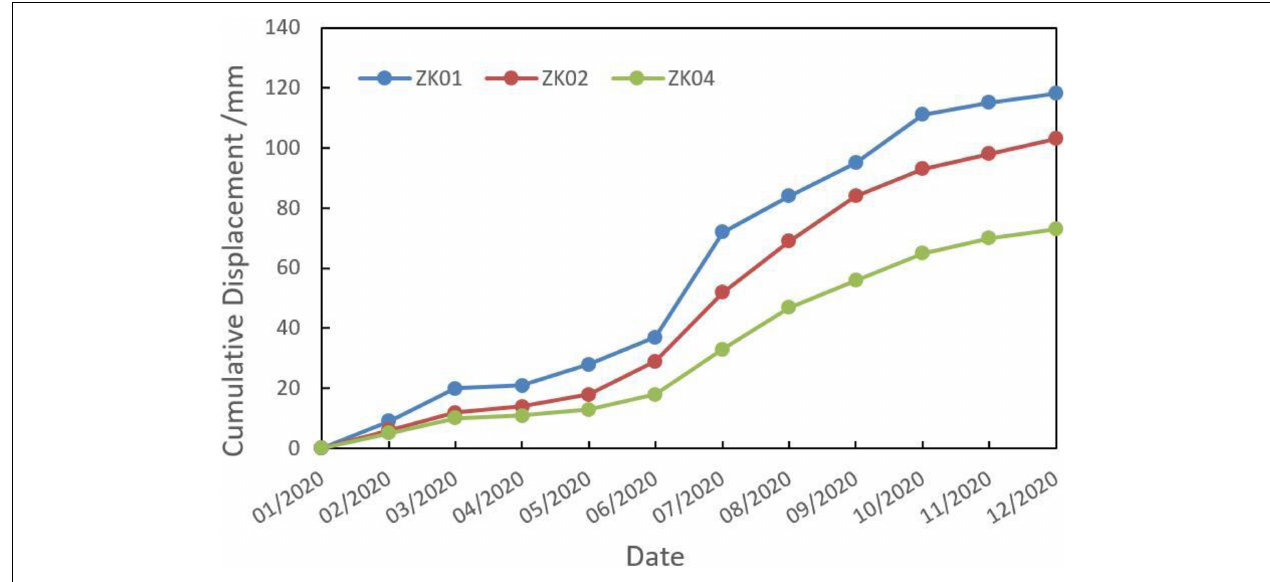
FIGURE 12 | GPS Monitoring data of displacement